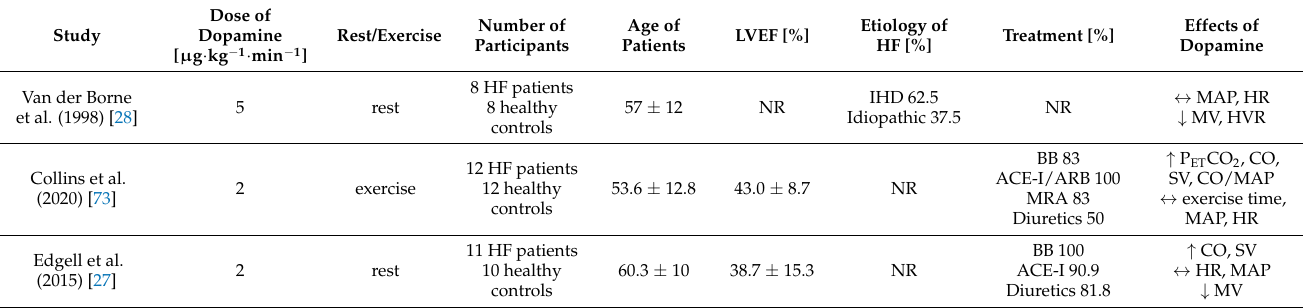
Table 3. Comparison of clinical studies using dopamine in HF